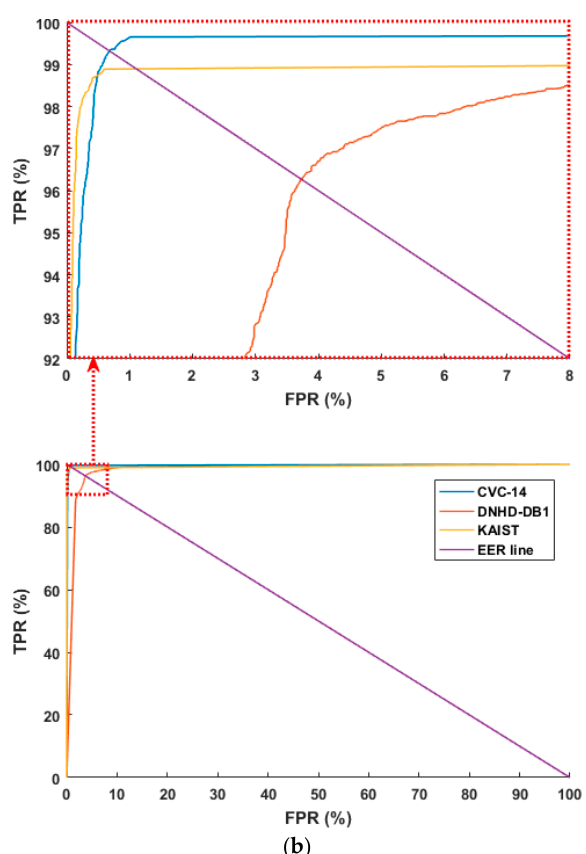
Figure 6. ROC curves of human and background detection: ( a ) with original images, ROC curves in the part ranges of FPR and TPR ( top ), ROC curves in the whole ranges of FPR and TPR ( bottom ) and ( b ) with HE processed images, ROC curves in the part ranges of FPR and TPR ( top ), ROC curves in the whole ranges of FPR and TPR ( bottom ). Table 6. Average testing accuracies of human and background detection with original images (unit: %).